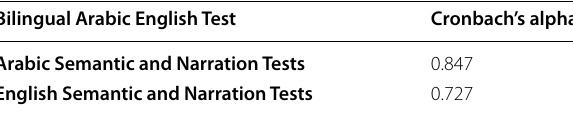
Table 14 Reliability of